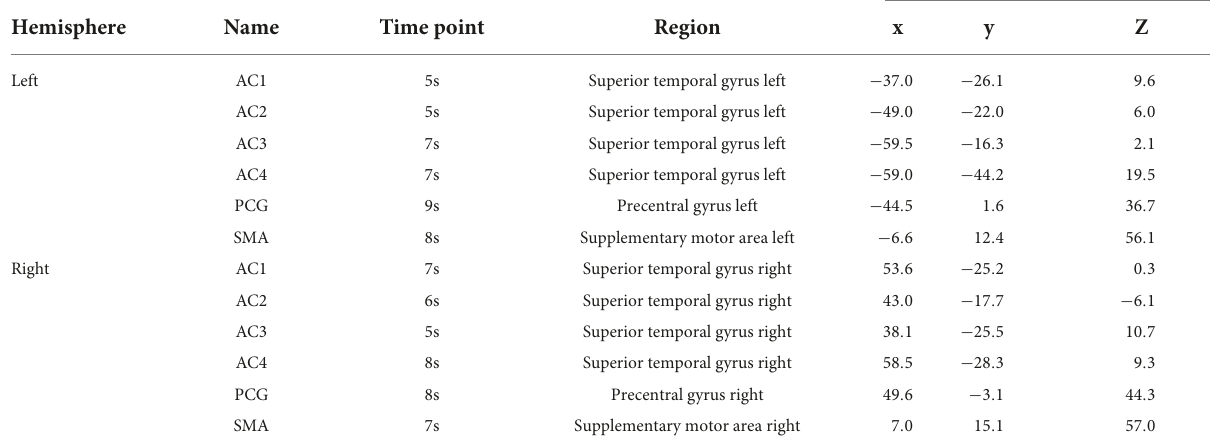
regression analysis results of the 12 ROIs are displayed in Figure 6